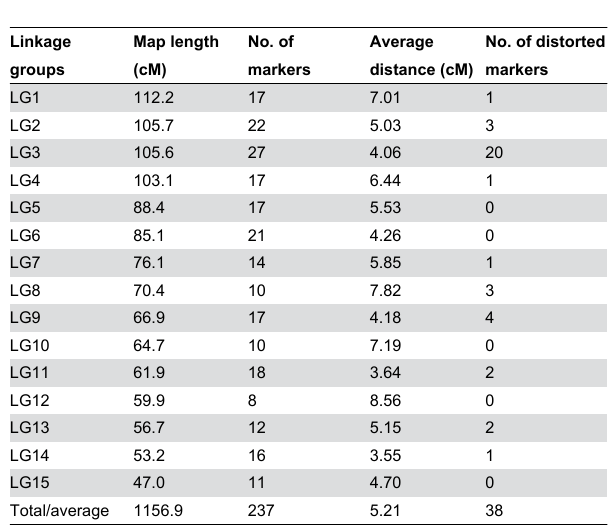
Table 3. Characteristics of each linkage group of the consensus